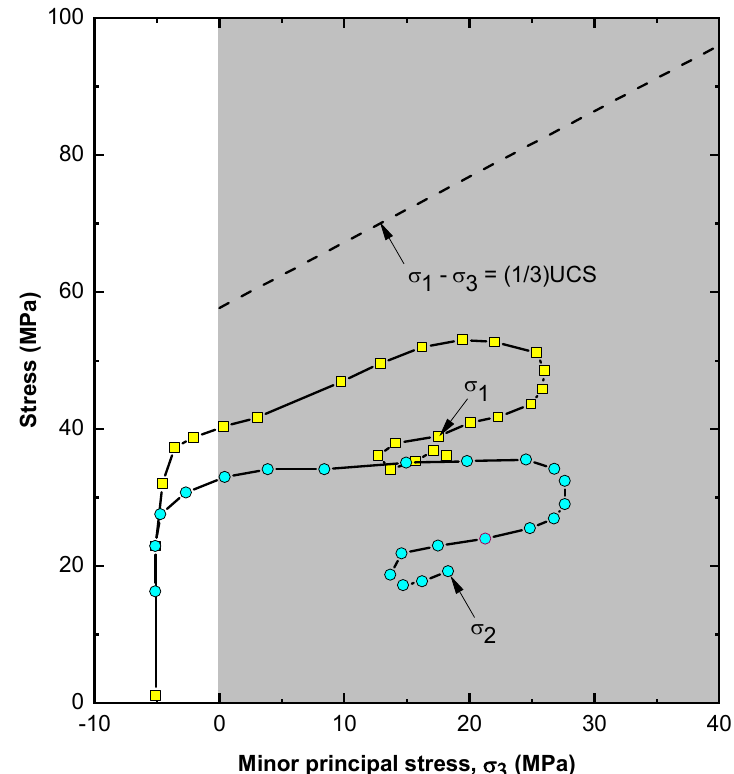
Figure 1. Stress path obtained for a point 50 mm above the crown of a mine-by tunnel using 3D numerical modelling ([9]). The Hoek–Brown (H–B) failure envelope and the stress path for direct tension, UCS, and triaxial tests are also shown. The thick dashed line represents the stress level above which crack initiates in rock.